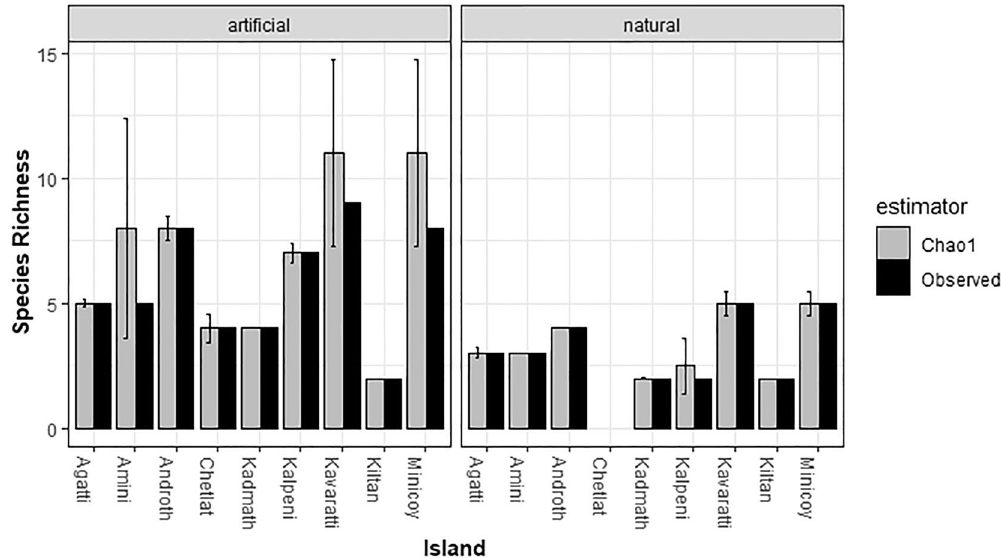
Figure 2. Observed and Chao 1 estimated mosquito richness in natural and artificial larval habitats on each island. The bars represent standard error.